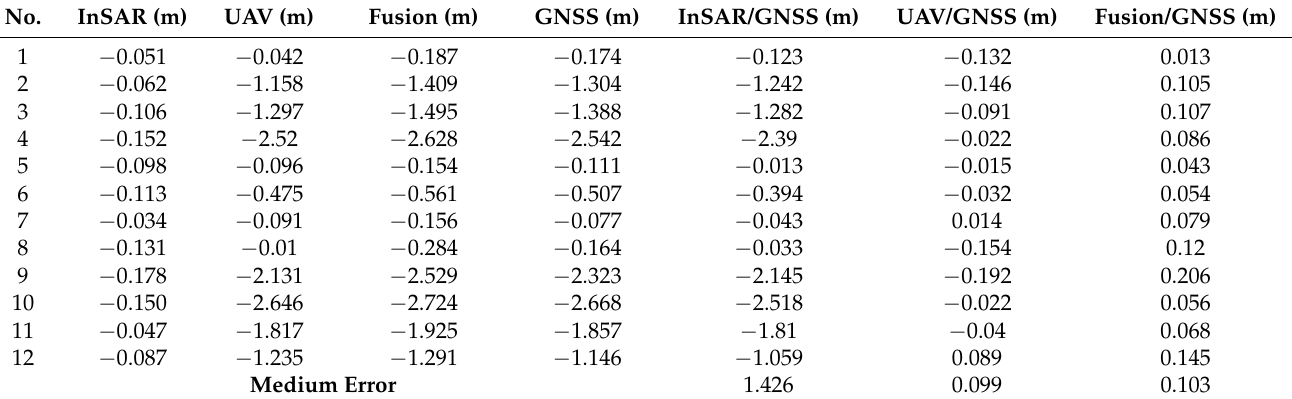
Table 3. Comparison of subsidence values between measured and fusion